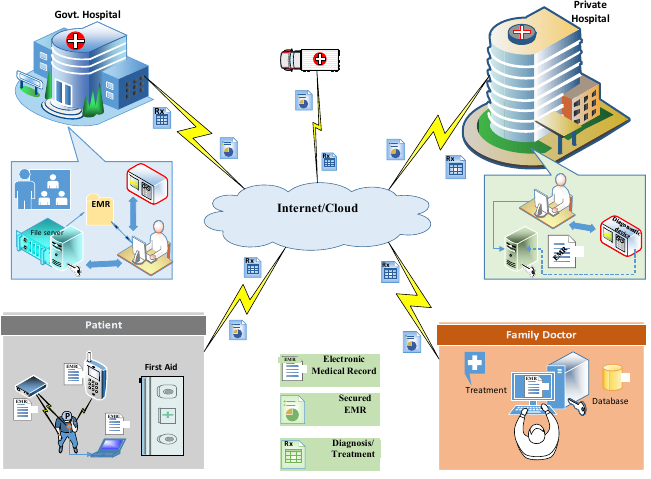
Figure 1. A typical smart-health system.